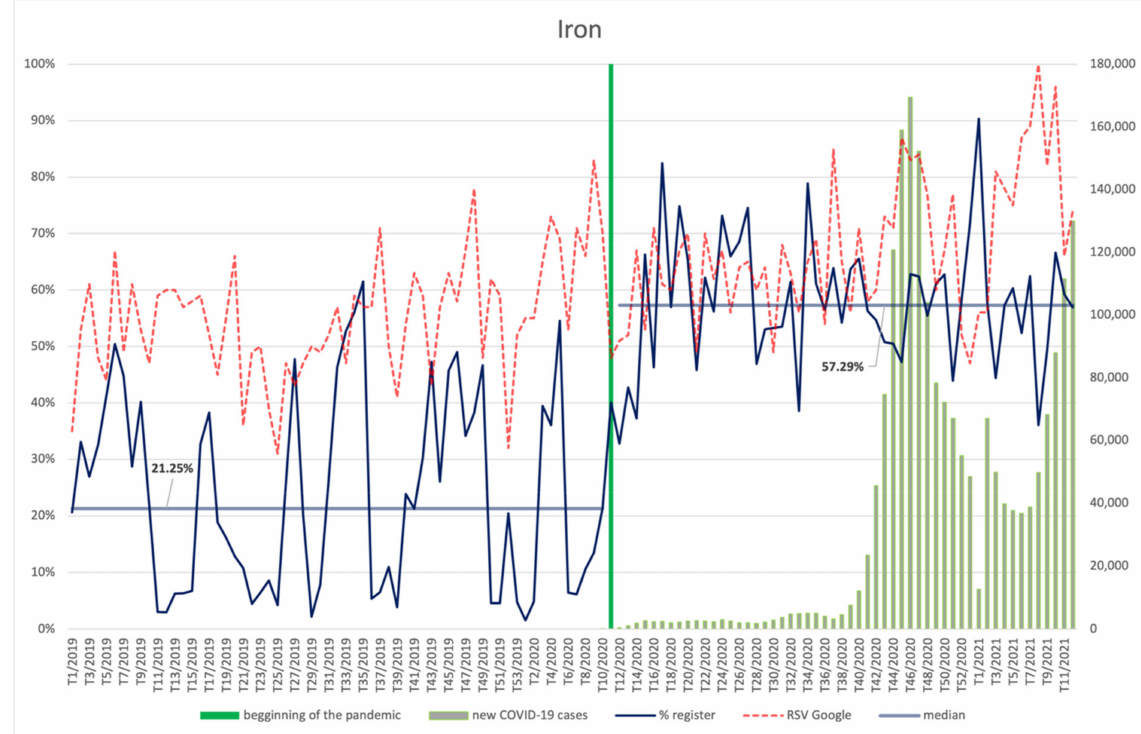
Figure 12. Comparison between the number of new registrations of products containing iron, the number of COVID-19 cases, and the frequency of search for information on the ingredient in the Google